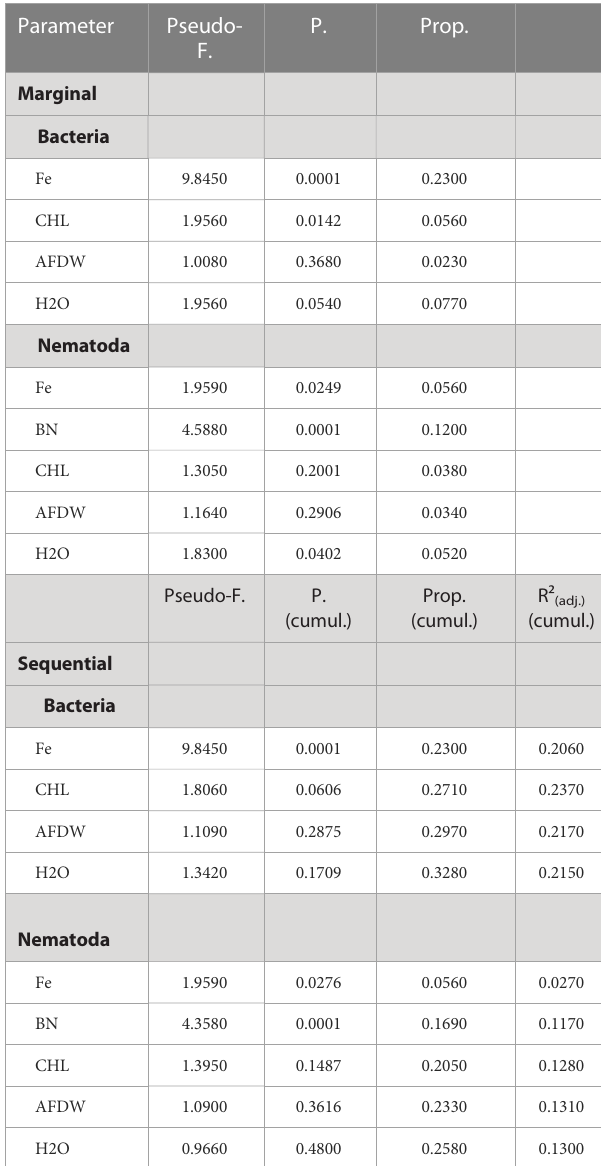
TABLE 5 DistLM (distance-based linear model) results showing the relationship between environmental (iron content, food availability and sedimentporosity) parameters on variation in nematode and bacteria community structure (Bray-Curtis similarity of square-root transformed abundance ofnematode and bacteria